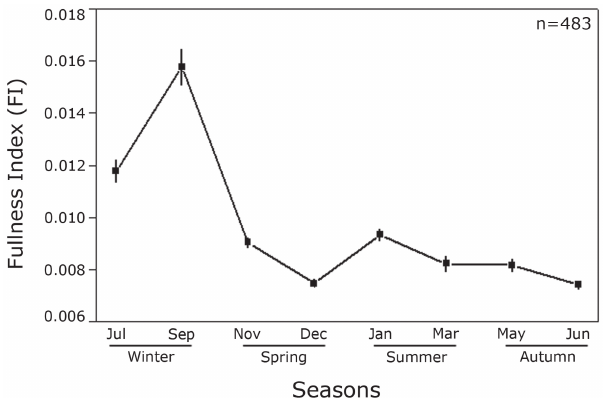
Fig. 9. Mean values (± standard error) of the fullness index between months and seasons of Cetengraulis edentulus in Guanabara